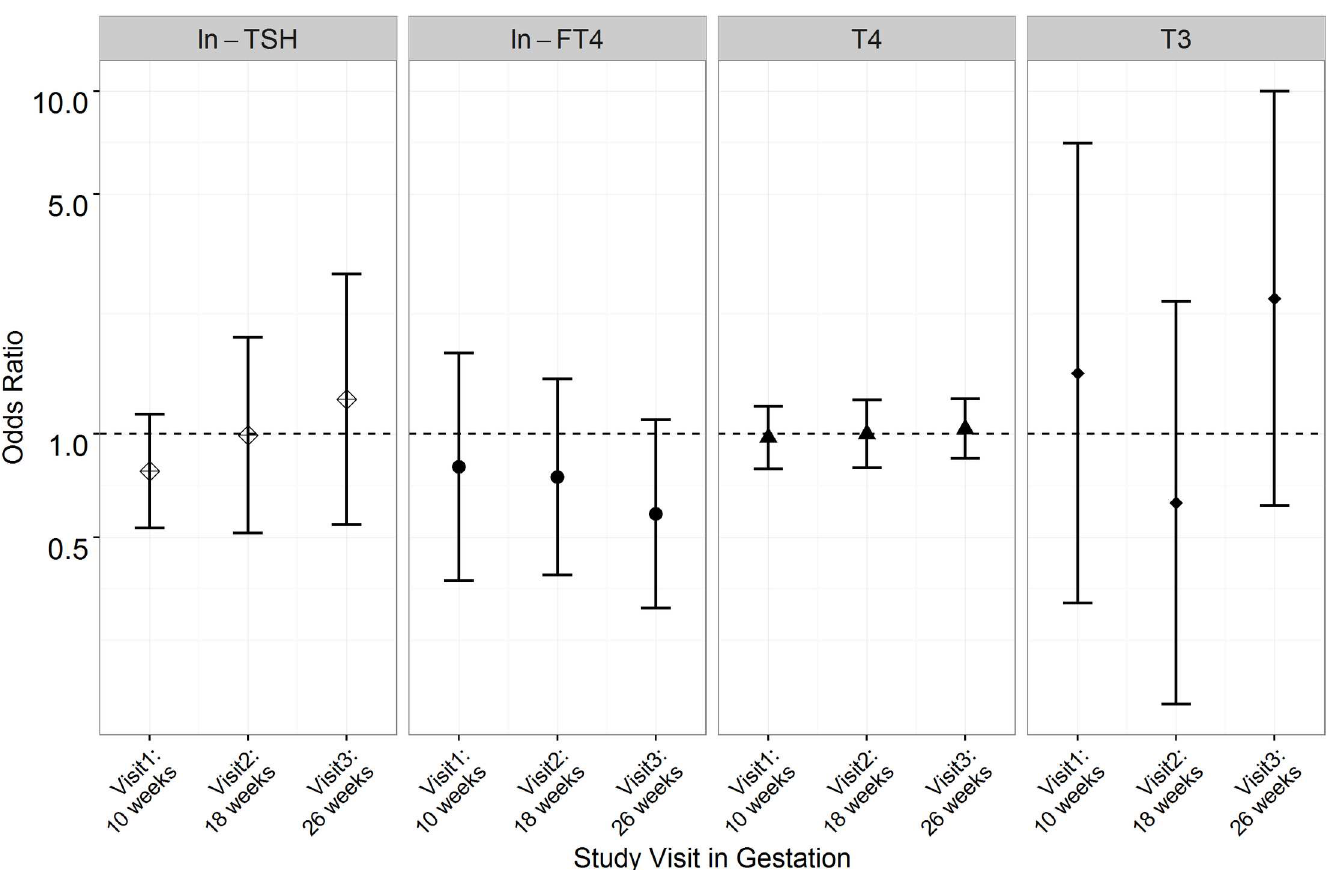
Fig 3. Adjusted odds ratios of placental pretermbirth (N = 33 cases)associated with a unit increasein thyroid hormone concentrations ( * p < 0.05).